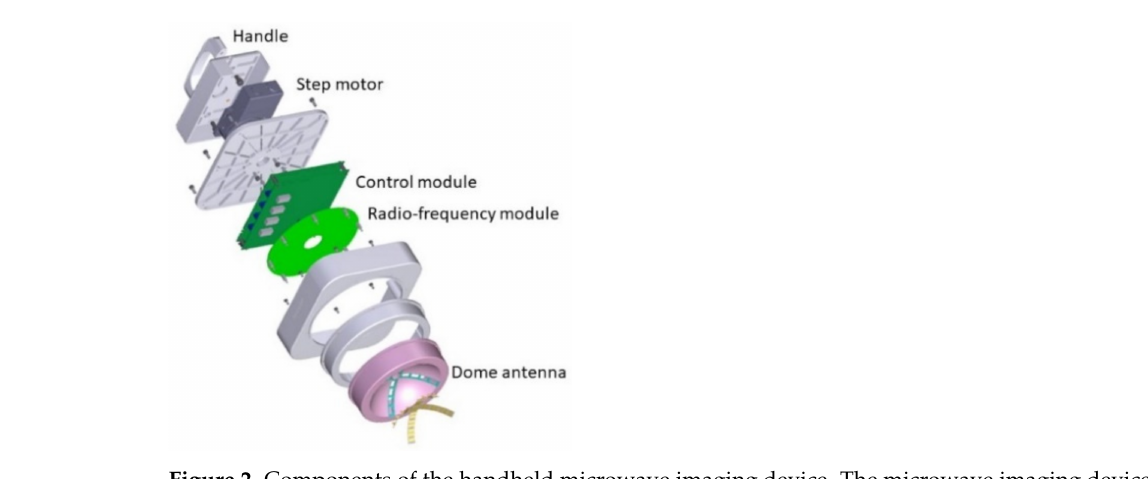
Figure 2. Components of the handheld microwave imaging device. The microwave imaging device comprises a handle, stepping motor, control module, radio-frequency module, and dome antenna.